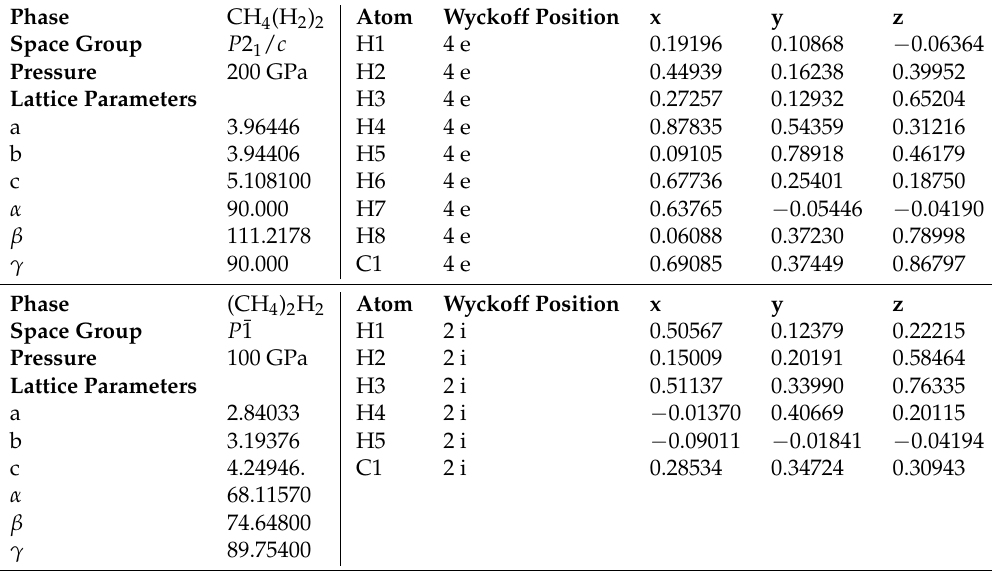
Table A2. Crystallographic information for the new CH 4 (H 2 ) 2 ( top ) and (CH 4 ) 2 H 2 phases ( bottom